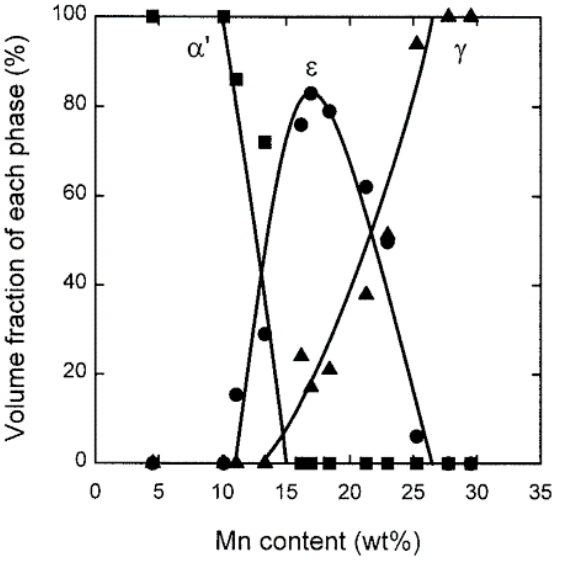
Figure 4. Volume fraction of each constituent phase in cast Fe − Mn alloys versus concentration of Mn in the alloy [52]. (Reproduced with permission from refs. [52]. Copyright (1997), ISIJ international).